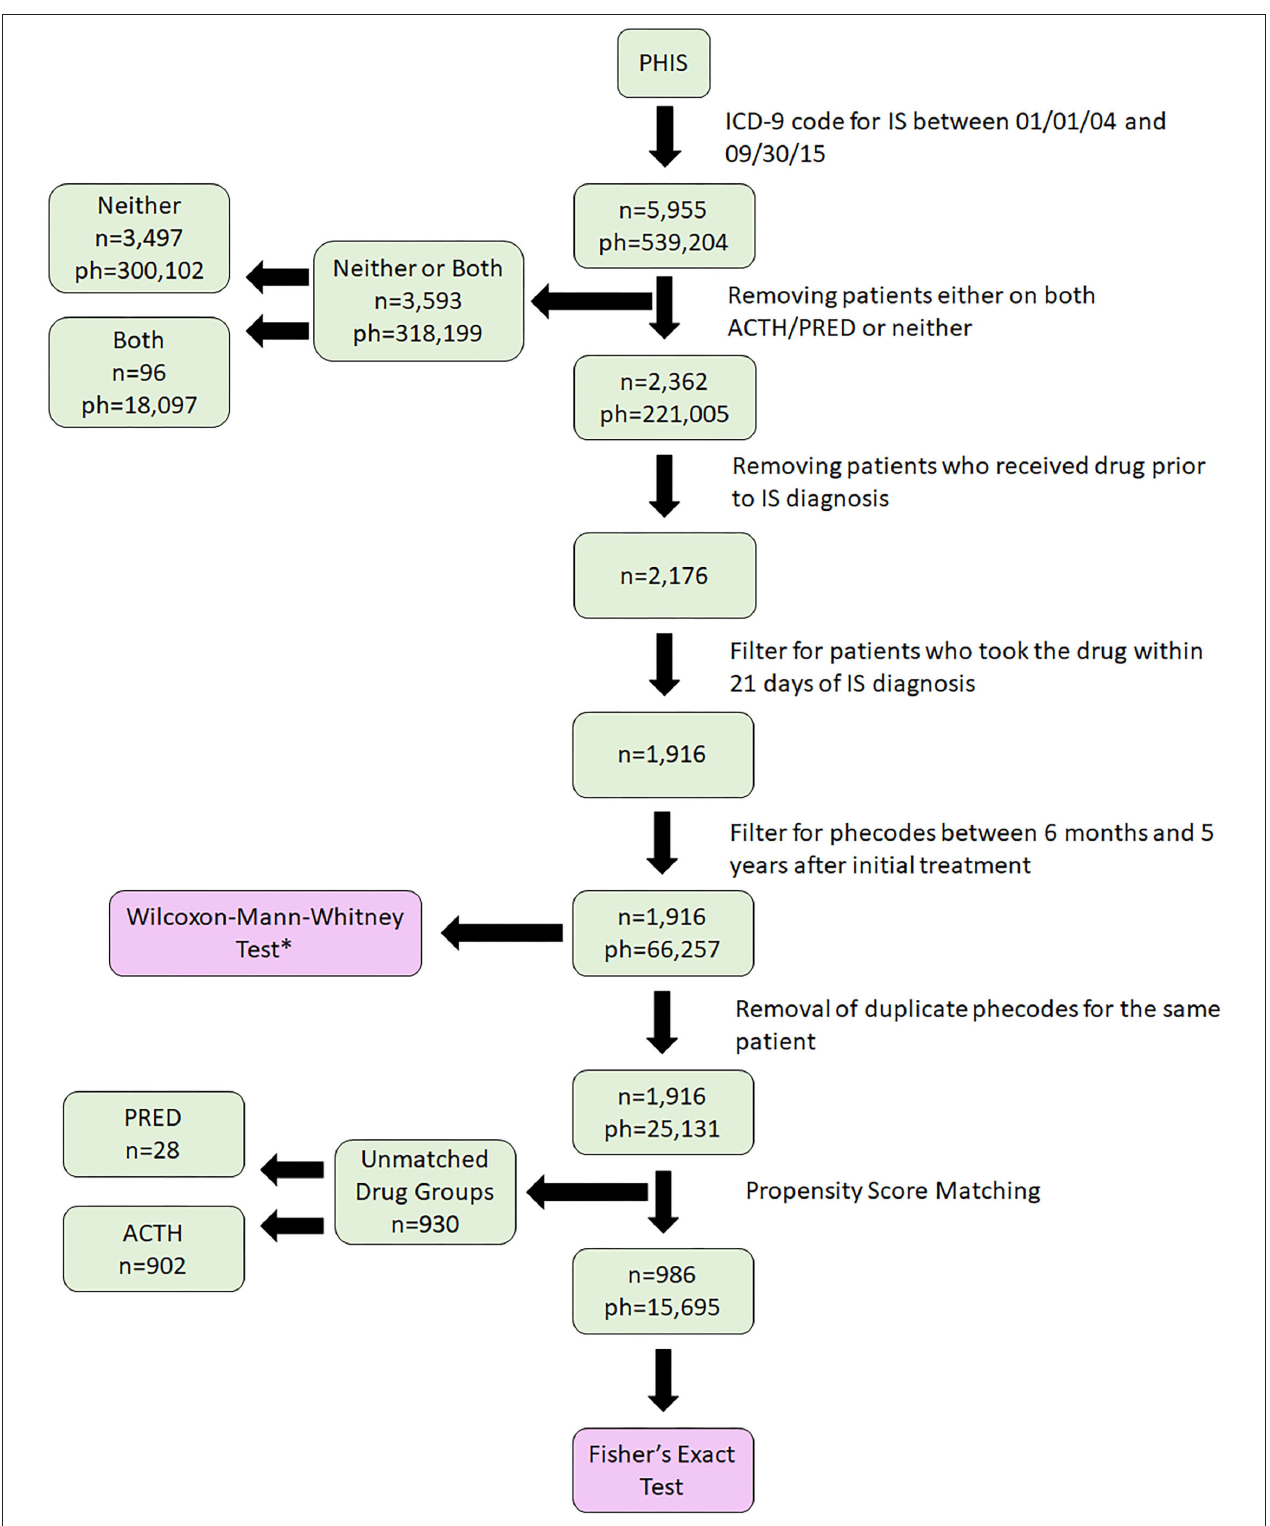
FIGURE 1 | Cohort identification. A total of 5,955 patients with infantile spasms (IS) were identified in Pediatric Hospital Information System (PHIS) using ICD-9 codes. We then filtered for medications and timeframe, performed propensity score matching, and finally, 986 patients were selected for analyses (493 in each drug cohort). IS, Infantile Spasms; ph, phecode; n, number of patients. *The dataset indicated for Wilcoxon-Mann-Whitney test is queried using match results.